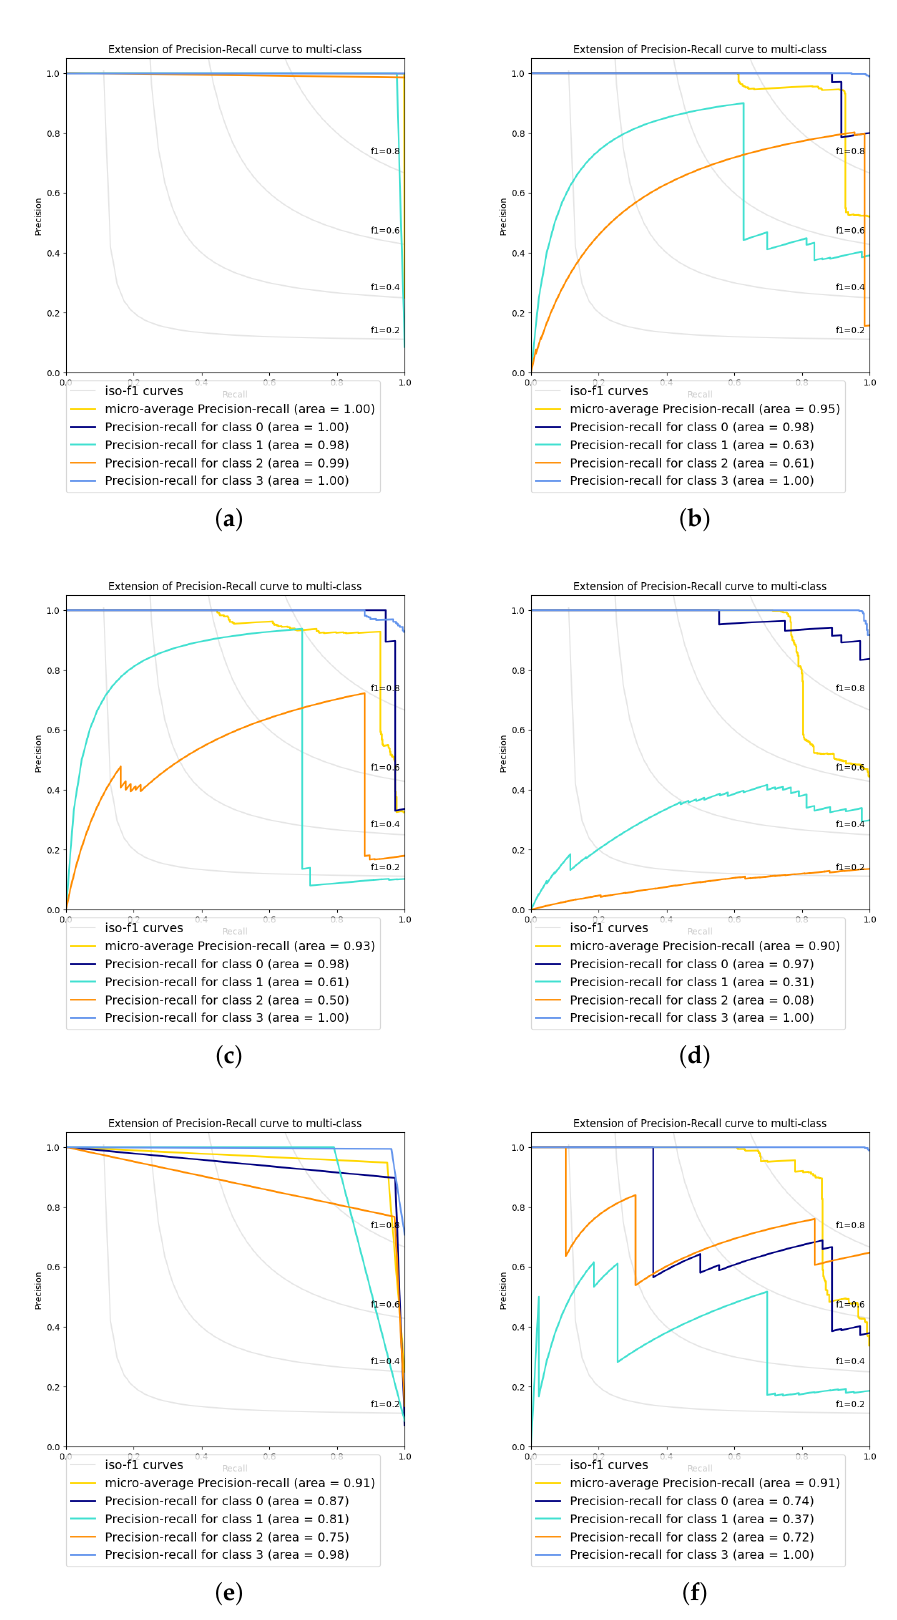
Figure 12. Precision and recall for the six classifiers ( a ) DTC, ( b ) SVM Poly, ( c ) SVM RBF, ( d ) SGD, ( e ) SVM Linear, and ( f ) NCA. The figures show the area of the curve for each growth stage, faults, and the model’s